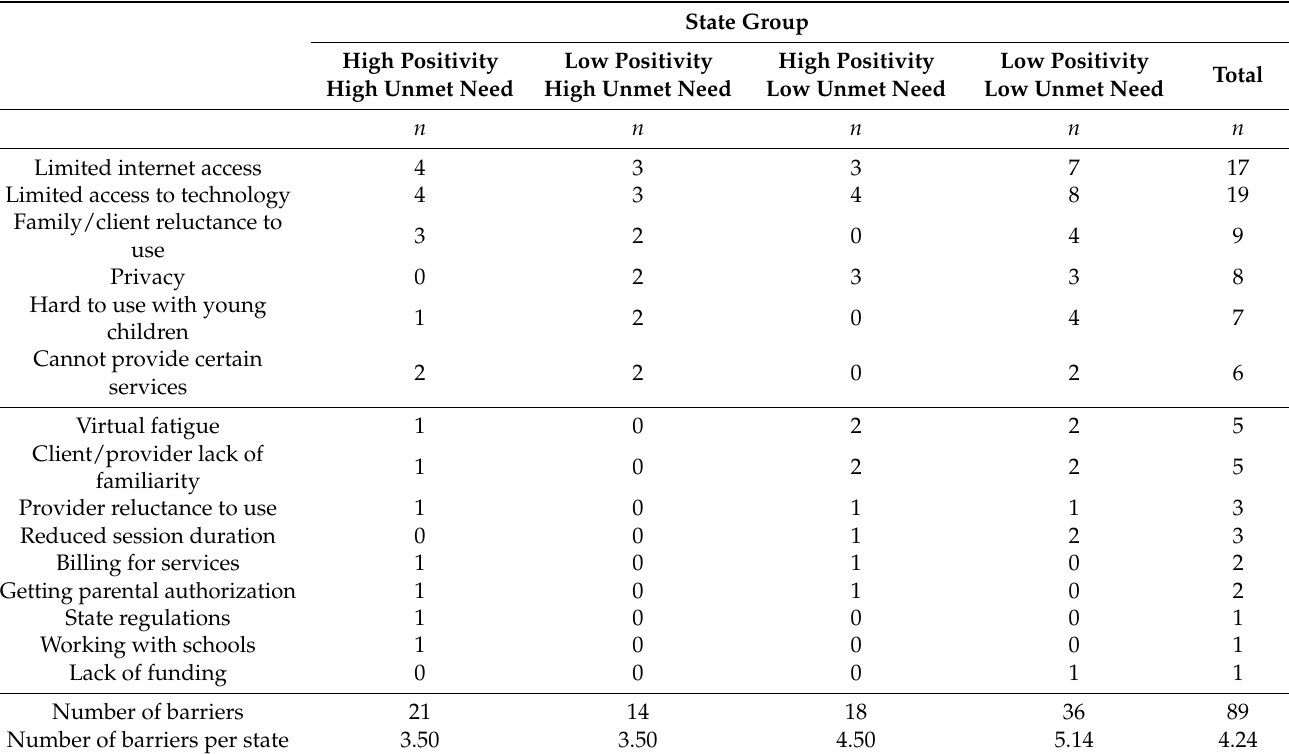
Table 5. Reported barriers to telehealth by levels of coronavirus positivity and unmet need for child and adolescent mental health